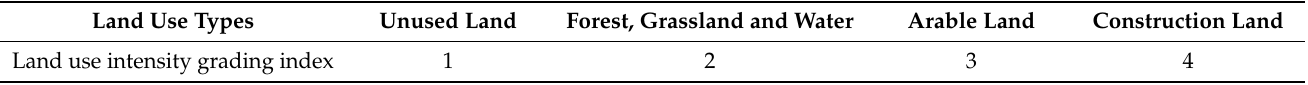
Table 1. Land use intensity assignment of different land use